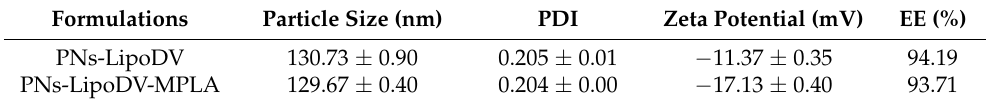
Table 1. Physicochemical characterizations and antigen encapsulation efficiency of PNs-based